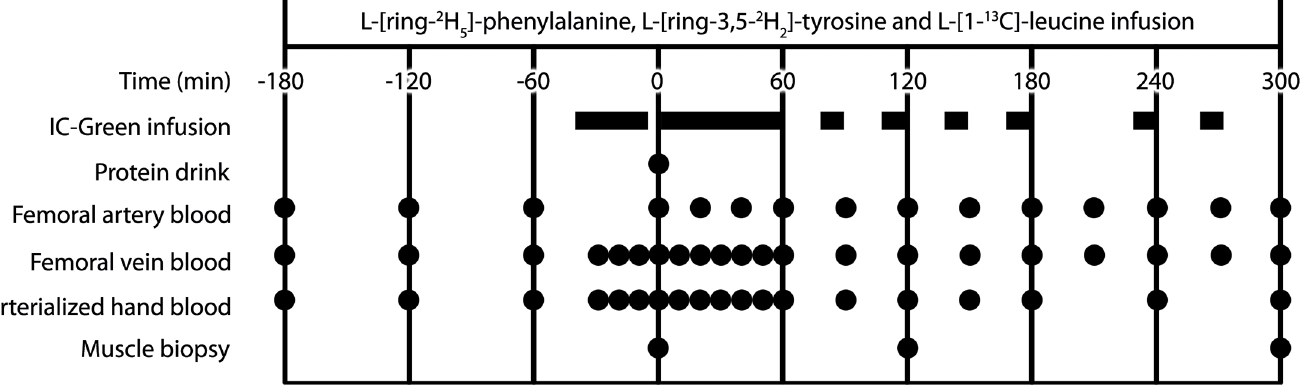
PLOS ONE | DOI:10.1371/journal.pone.0141582 November 10,